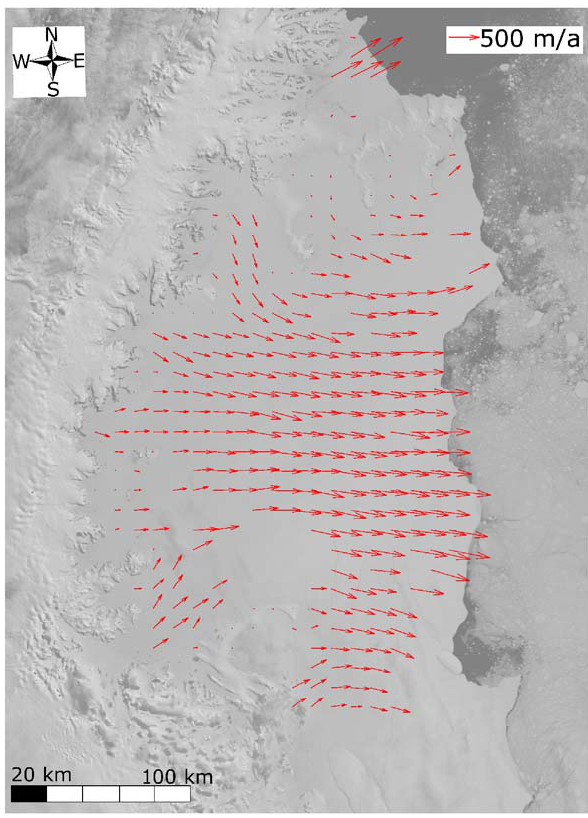
Fig. 4. Average annual velocity between 2006 and 2009 measured with orientation correlation on MODIS images.